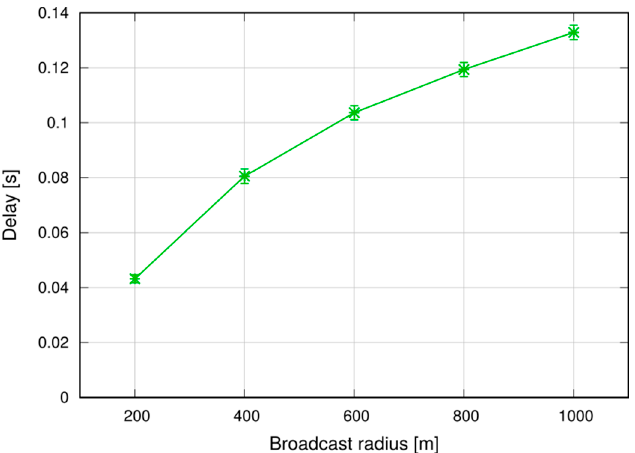
Figure 28. 95th percentile of broadcasting delay.